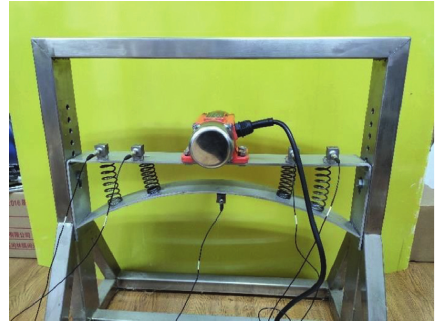
Figure 26: Composite beam structure and